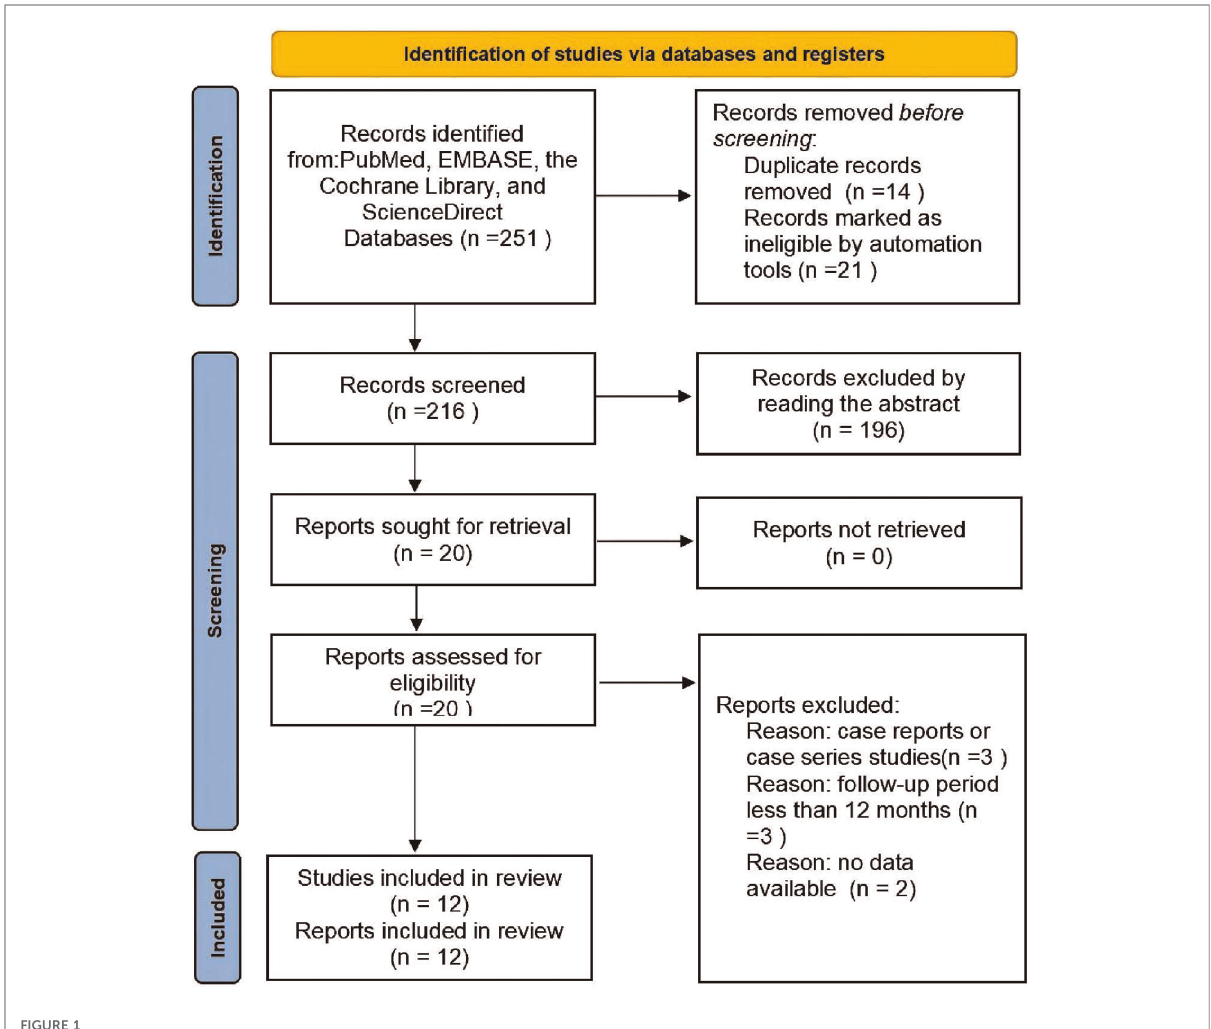
FIGURE 1 PRISMA fl